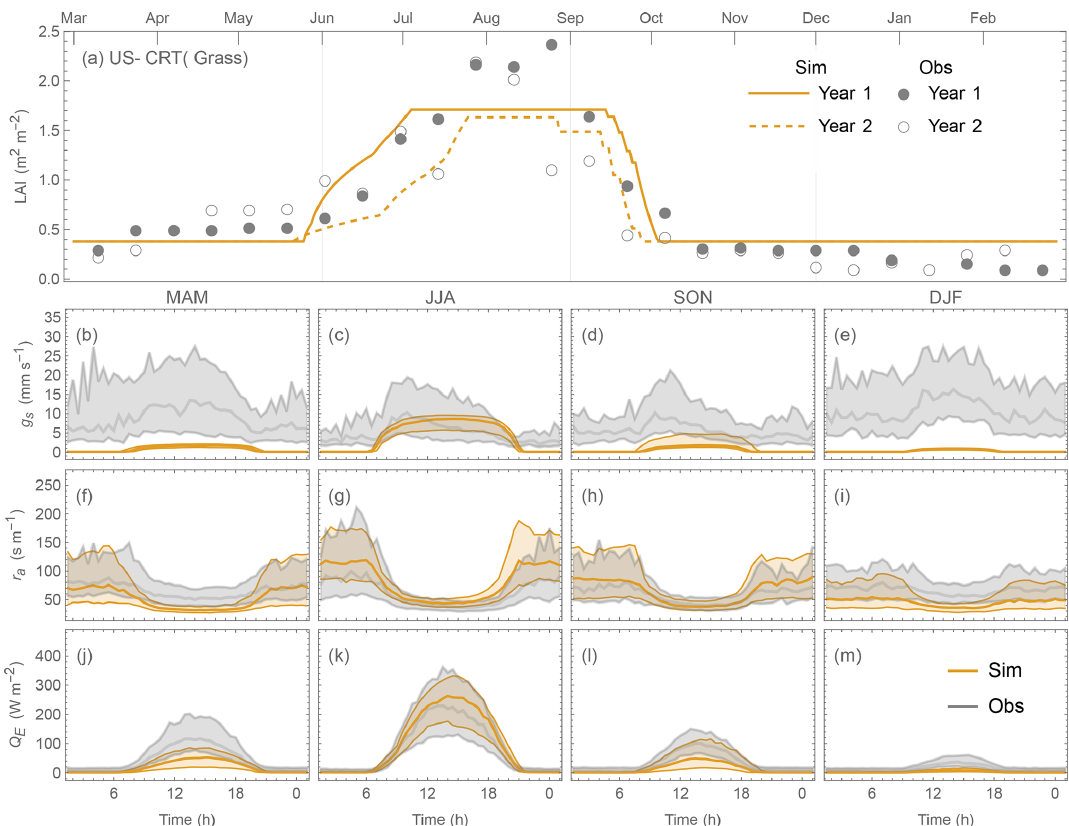
Figure 24. As Fig. 19, but for US-CRT (Grass, PS =